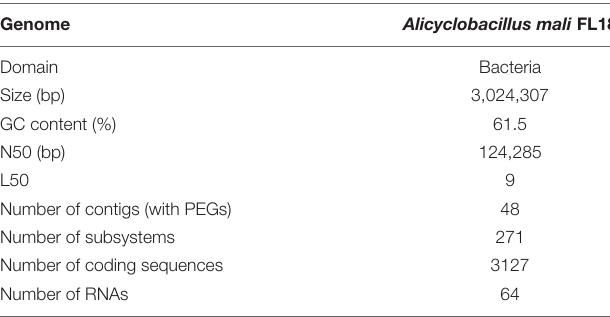
TABLE 2 | Genome statistics of Alicyclobacillus mali